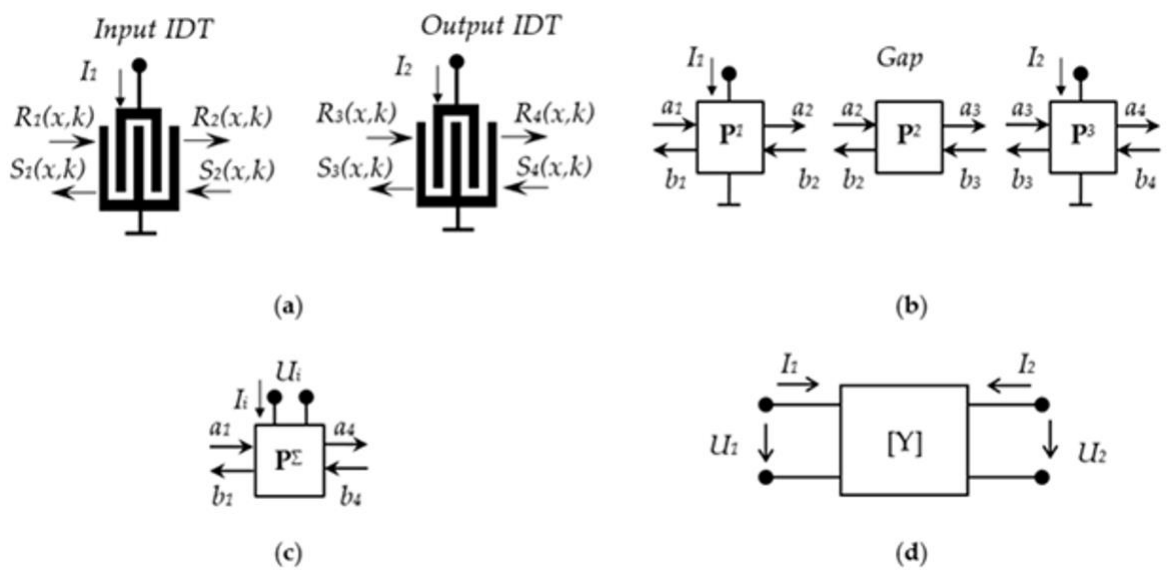
Figure 3. SAW DL as: ( a ) topology; ( b ) blocks for P-matrix; ( c ) final P-matrix and ( d ) two port device. I and U —the current and voltage at the electrical